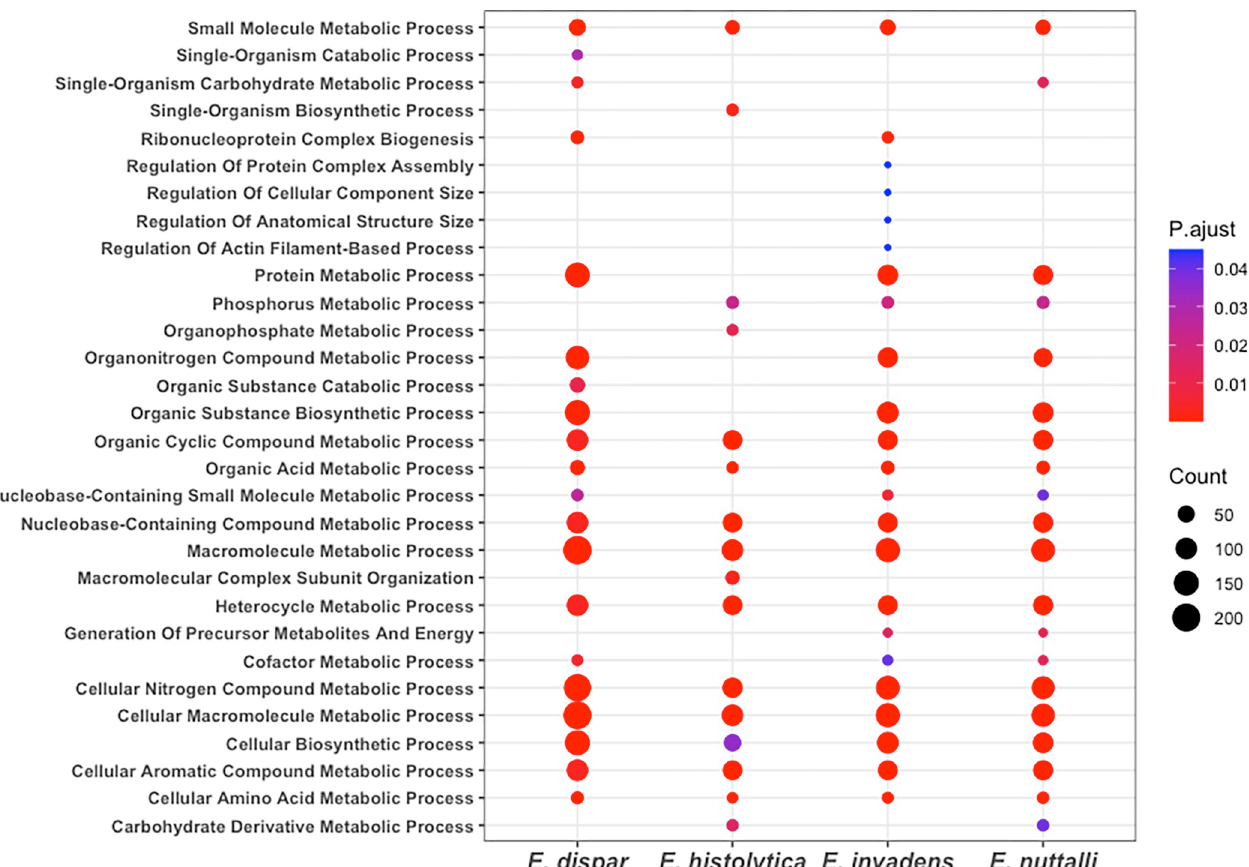
Fig 5. GO enrichment analysis. The dot plot shows the terms (FDR < 0.05) of biological processes identified using DAVID. The size of a dot represents the number of genes associated with the GO term, and the color of dots represents the P-adjusted